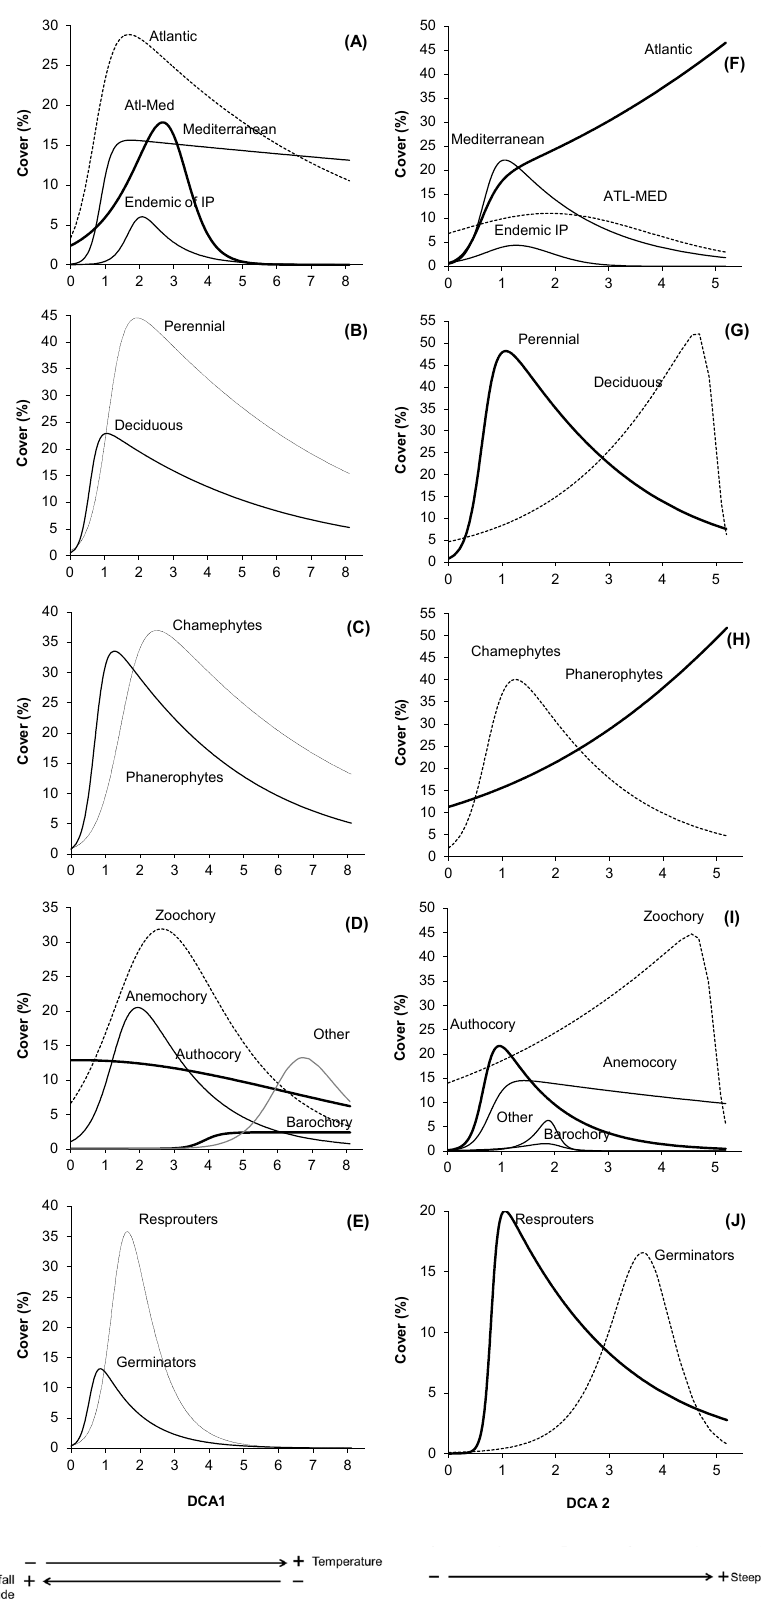
Figure 3. HOF-derived response curves for shrub functional groups in Palencia (Northern Spain), relative to the first ( A – E ) and second ( F – J ) coenoclines (DCA1 and DCA2, respectively); ( A , F ): geo- graphical distribution, ( B , G ): biotype, ( C , H ): Raunkiær´s life-form, ( D , I ): dispersal mode, and ( E , J ): regeneration method.